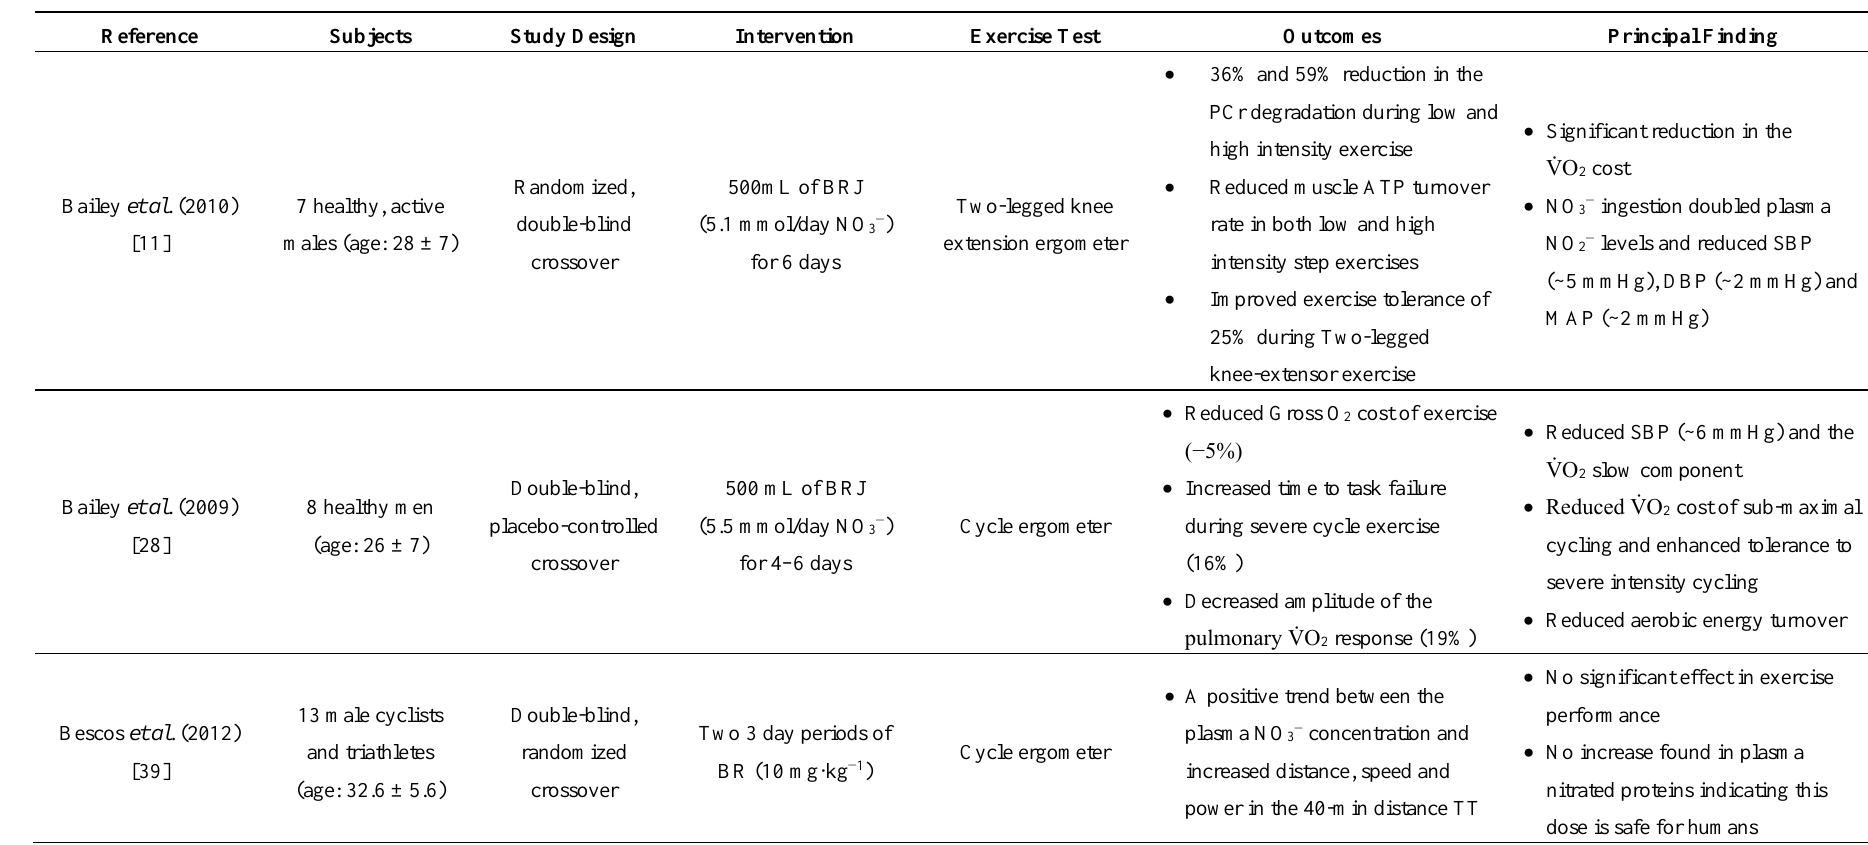
Table 1. Studies focused on the impact of nitrate ingestion on exercise